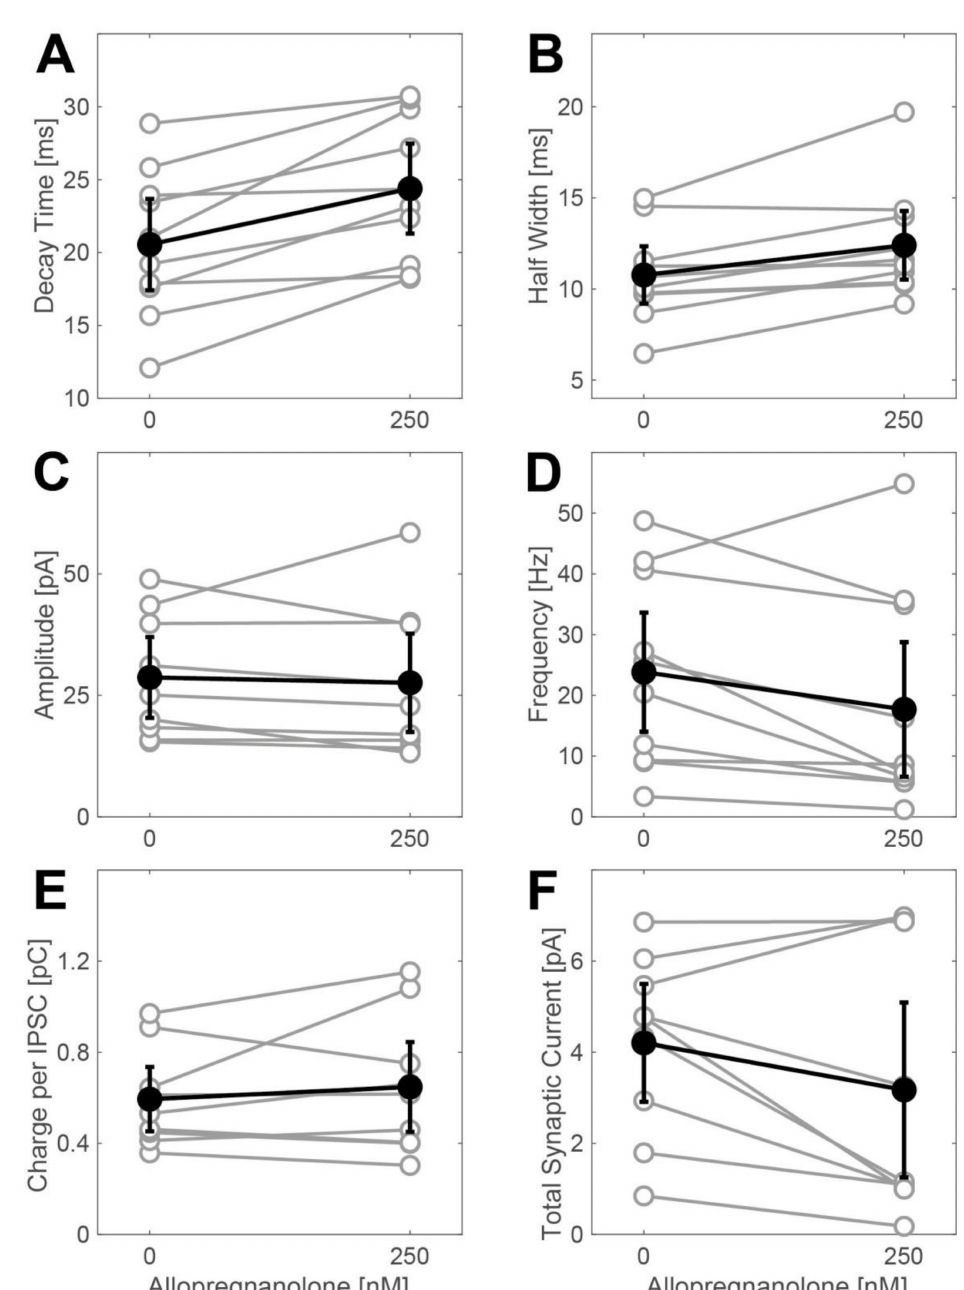
Figure A1. E ff ects of allopregnanolone (250 nM) on phasic currents in spinal interneurons. All data are given as the mean including the 95% confidence interval. A significant increase in the IPSC decay